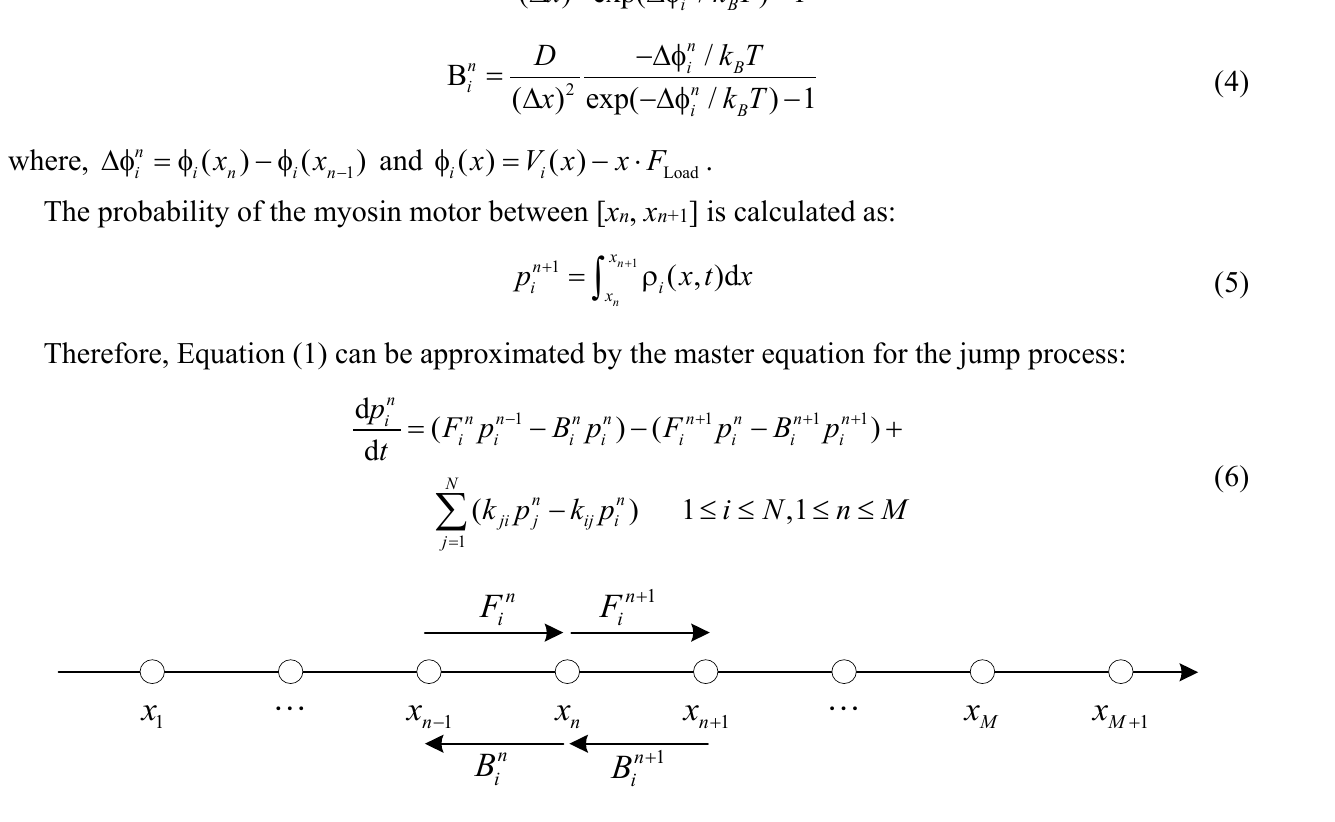
Figure 1. The spatial discretization and jump rates between two